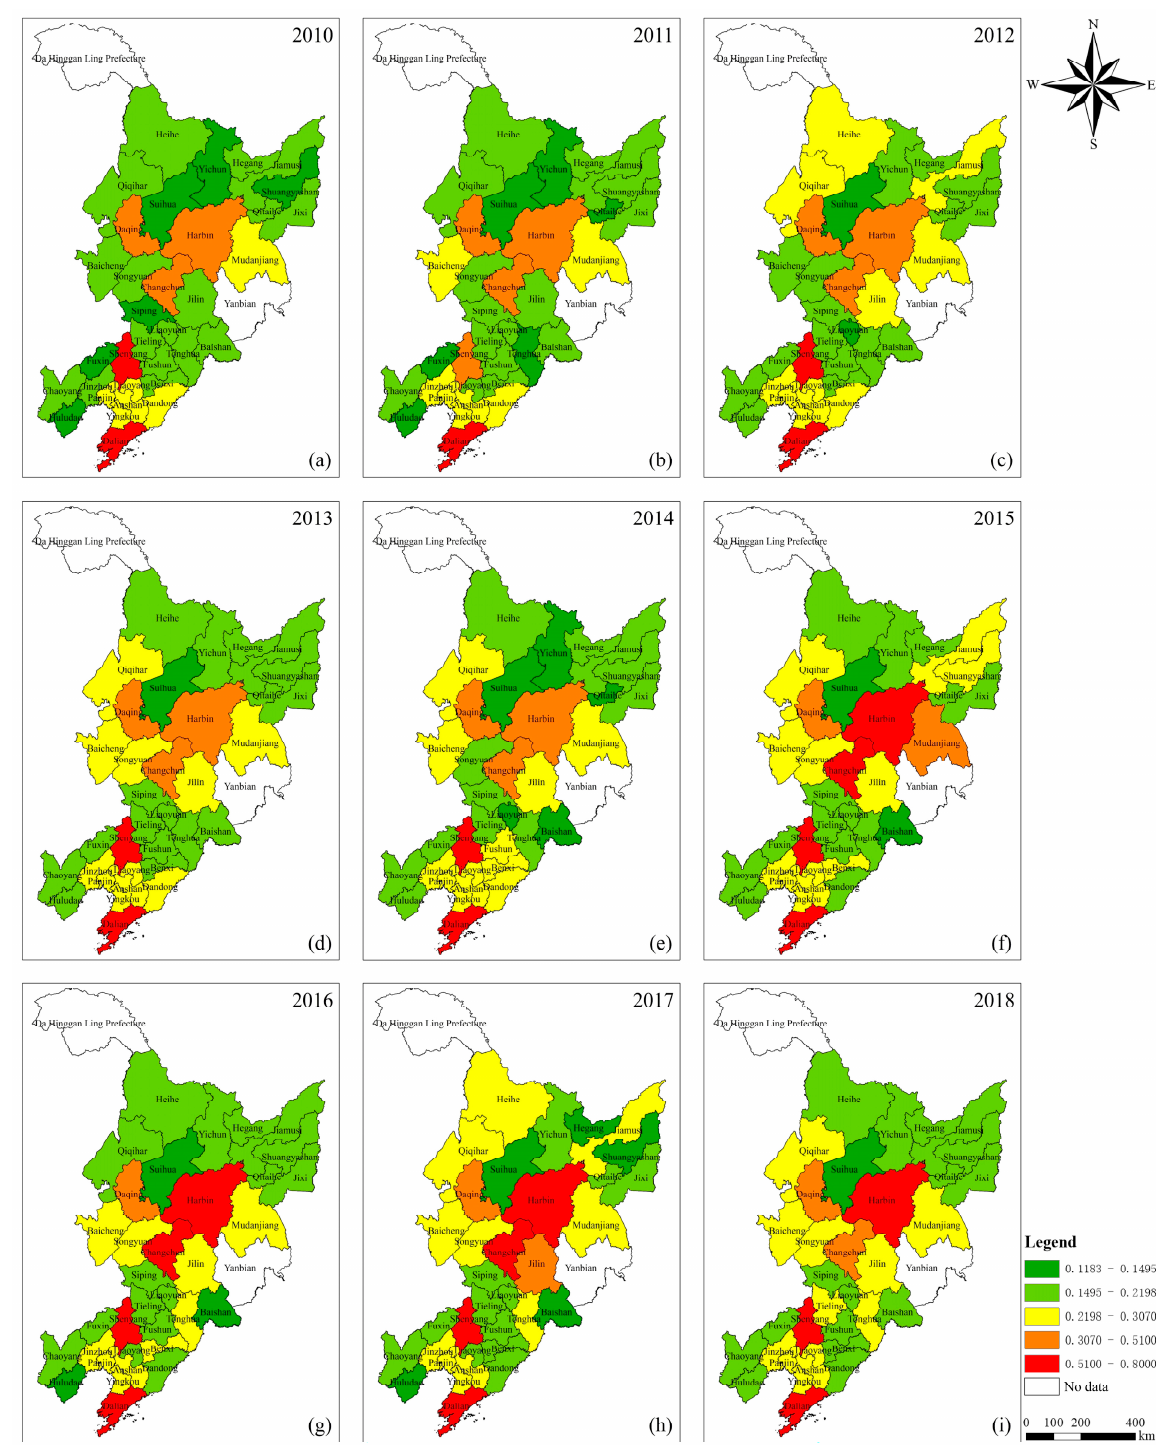
Figure 3. Variations of urban vitality of cities in three northeastern provinces of China from 2010 to 2018. Note: In order to visualize the results better, the municipal districts are shown as administrative regions. And ( a – i ) respectively correspond to the subfigures of 2010–2018, marking their correct order.